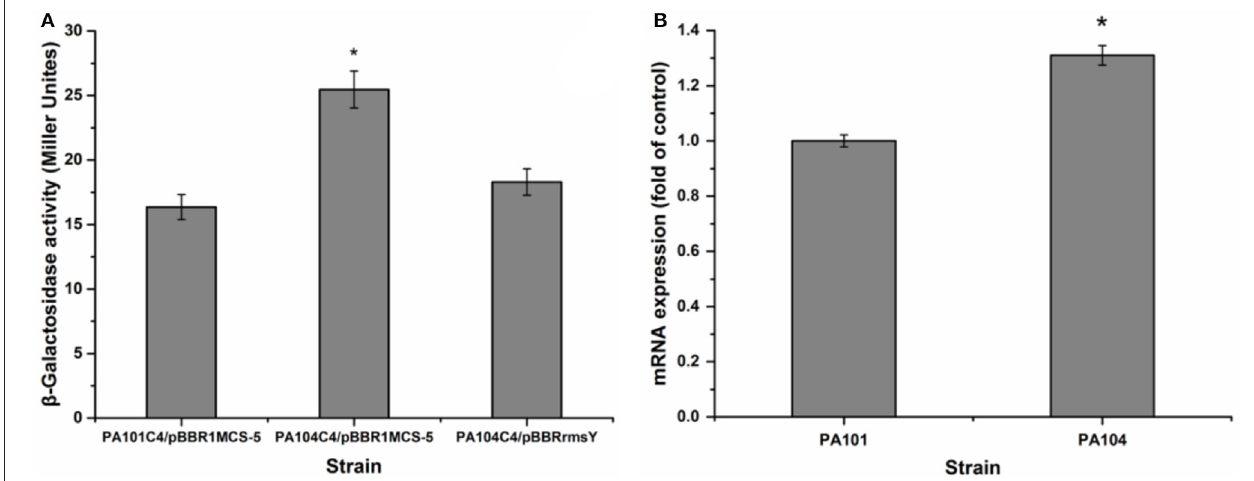
FIGURE 5 | Effect of rsmY-mutant on rsmA expression. (A) Effect of rsmY mutant on expression of chromosome-borne translationally fused rsmA ’-‘ lacZ (bar 1, control strain PA101C4/pBBR1MCS-5; bar 2, rsmY-mutant strain PA104C4/ pBBR1MCS-5; bar 3, rsmY-overexpression strain PA104C4/pBBRrsmY). (B) rsmA expression in control strain PA101 (lane 1) and rsmY-mutant strain PA104 (lane 2) by qRT-PCR. Experiments were in triplicate. * P < 0.05 compared with control.